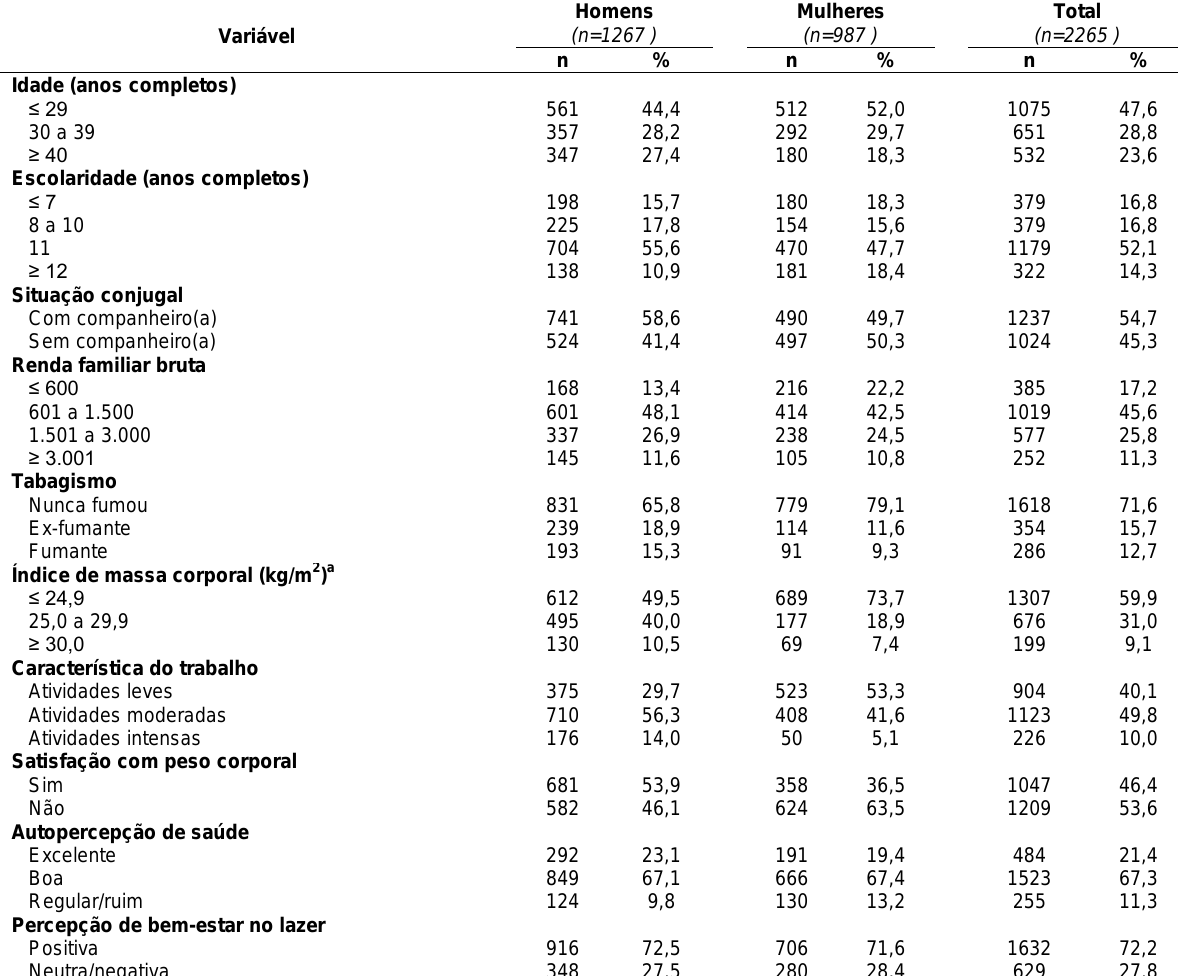
Tabela 1. Descrição dos trabalhadores da indústria conforme características sociodemográficas, comportamentais e de saúde estratificada por sexo e na amostra total. Rio Grande do Sul,